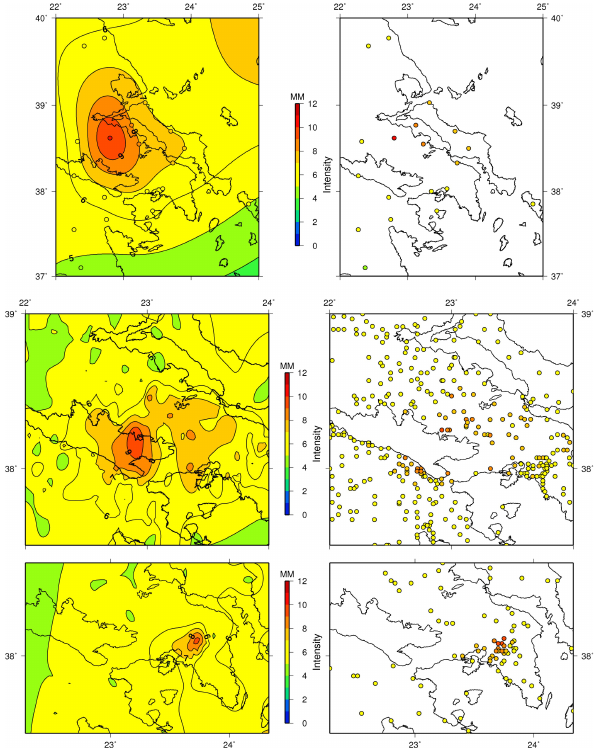
Fig. 1. Example of Isoseisms constructed by the kriging method- ology and corresponding macroseismic data for 3 earthquakes in